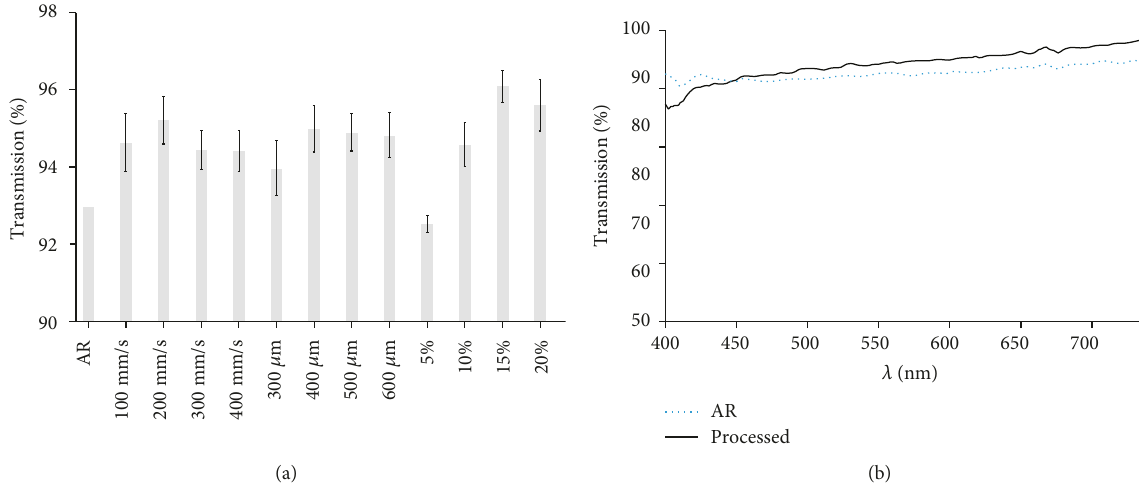
Figure 4: (a) The averaged transmission values from 400 to 750 nm for each of the laser parameters tested and the unprocessed AR sample. The error bars show the standard error of the mean. (b) A comparison between the transmission spectra of the as-received PET sample and those of the sample that produced the highest haze.